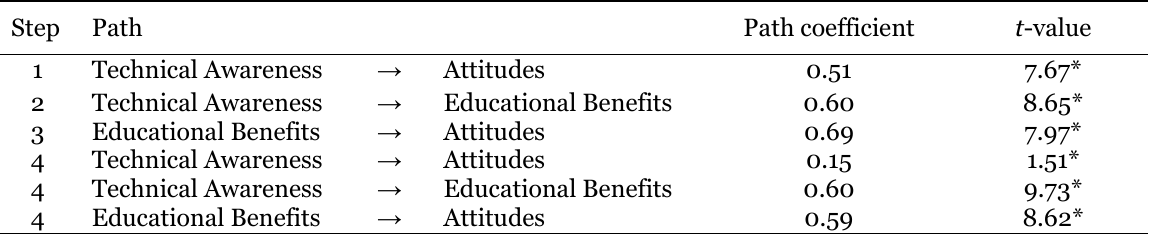
Student Results for Technical Awareness, Educational Benefits, and Attitudes